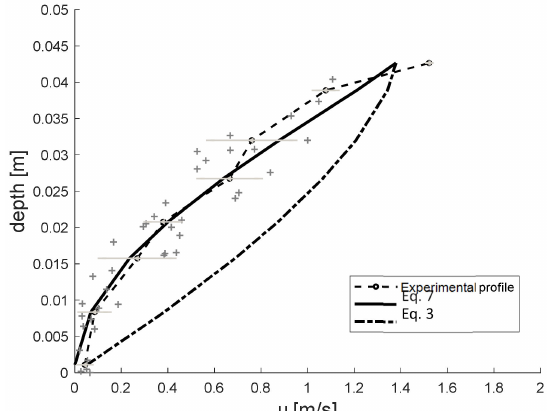
Figure 7. Comparison between the u profile (experimental profile) and the estimated ones by applying Equation (3) and by applying Equation (7). The dots represent the velocity u of selected grains (the x -axis indicates the longitudinal velocity; the y -axis indicates the distance from the upper level of the static